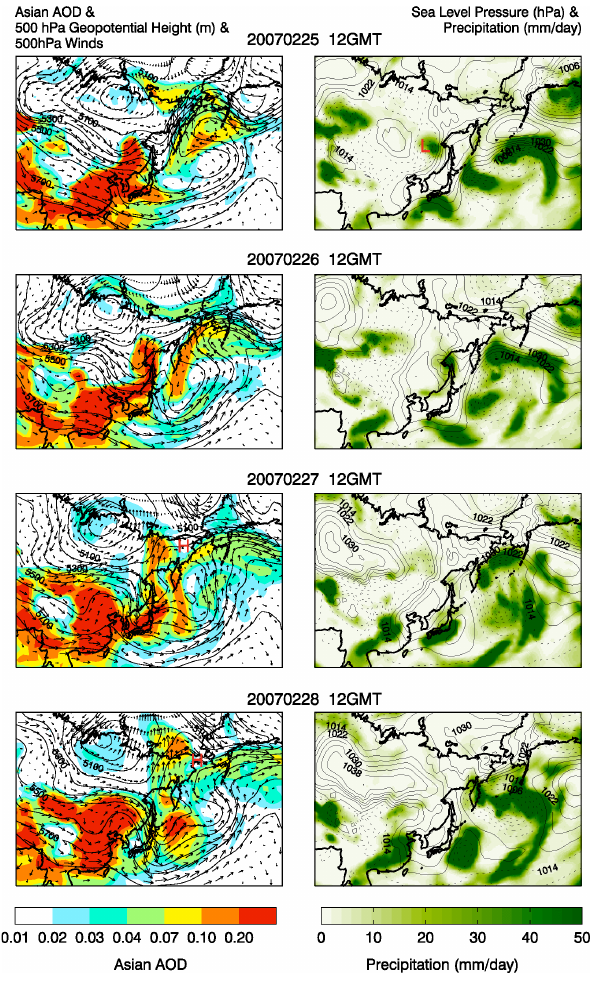
Figure 3. Left panel: 500 hPa geopotential height (black contours) and corresponding wind vector evolution during the Fig. 3. Left panel: 500hPa geopotential height (black contours) initial period of aerosol export, together with GEOS-Chem Asian AOD (in color) for February 25-28, 2007. Right panel: and corresponding wind vector evolution during the initial period Sea level pressure (contours) and precipitation (green). SLP contours (4 hPa) are dashed when SLP is below 1014 hPa. H of aerosol export, together with GEOS-Chem Asian AOD (in color) indicates the blocking high pressure system; L shows the location of the low pressure center. for 25–28 February 2007. Right panel: Sea level pressure (con- tours) and precipitation (green). SLP contours (4hPa) are dashed when SLP is below 1014hPa. H indicates the blocking high pres- sure system; L shows the location of the low pressure